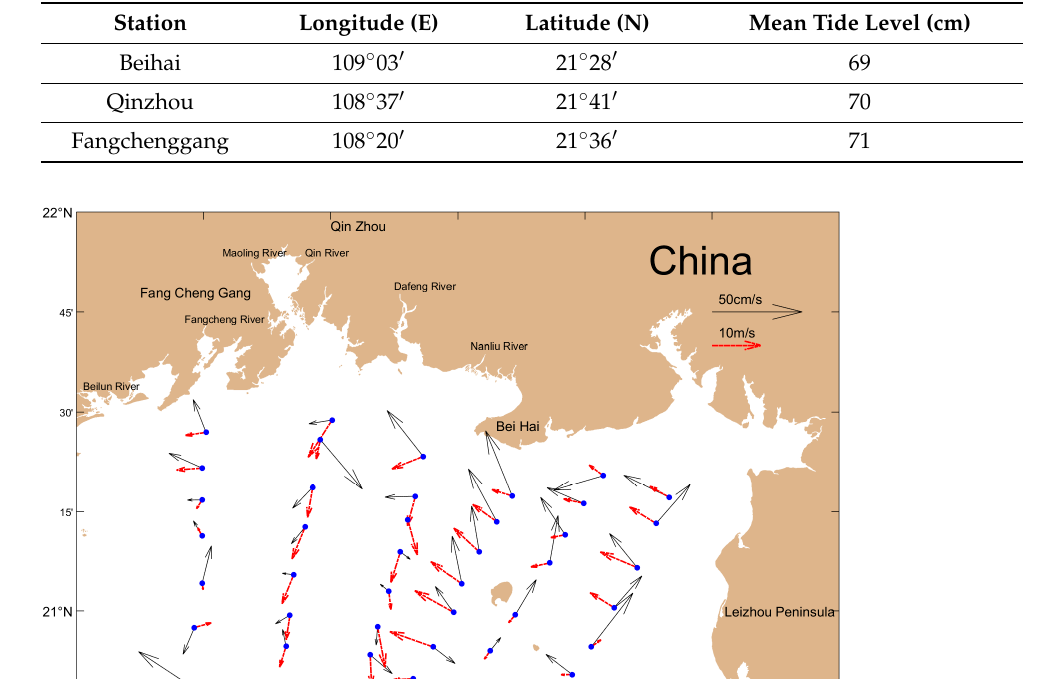
Figure 3. Distribution of currents (black arrows) and wind fields (red dashed arrows) during the sampling period in May 2021. Table 1. Mean sea level at Beihai, Qinzhou, and Fangchenggang stations (unit: cm, reference datum: 85).